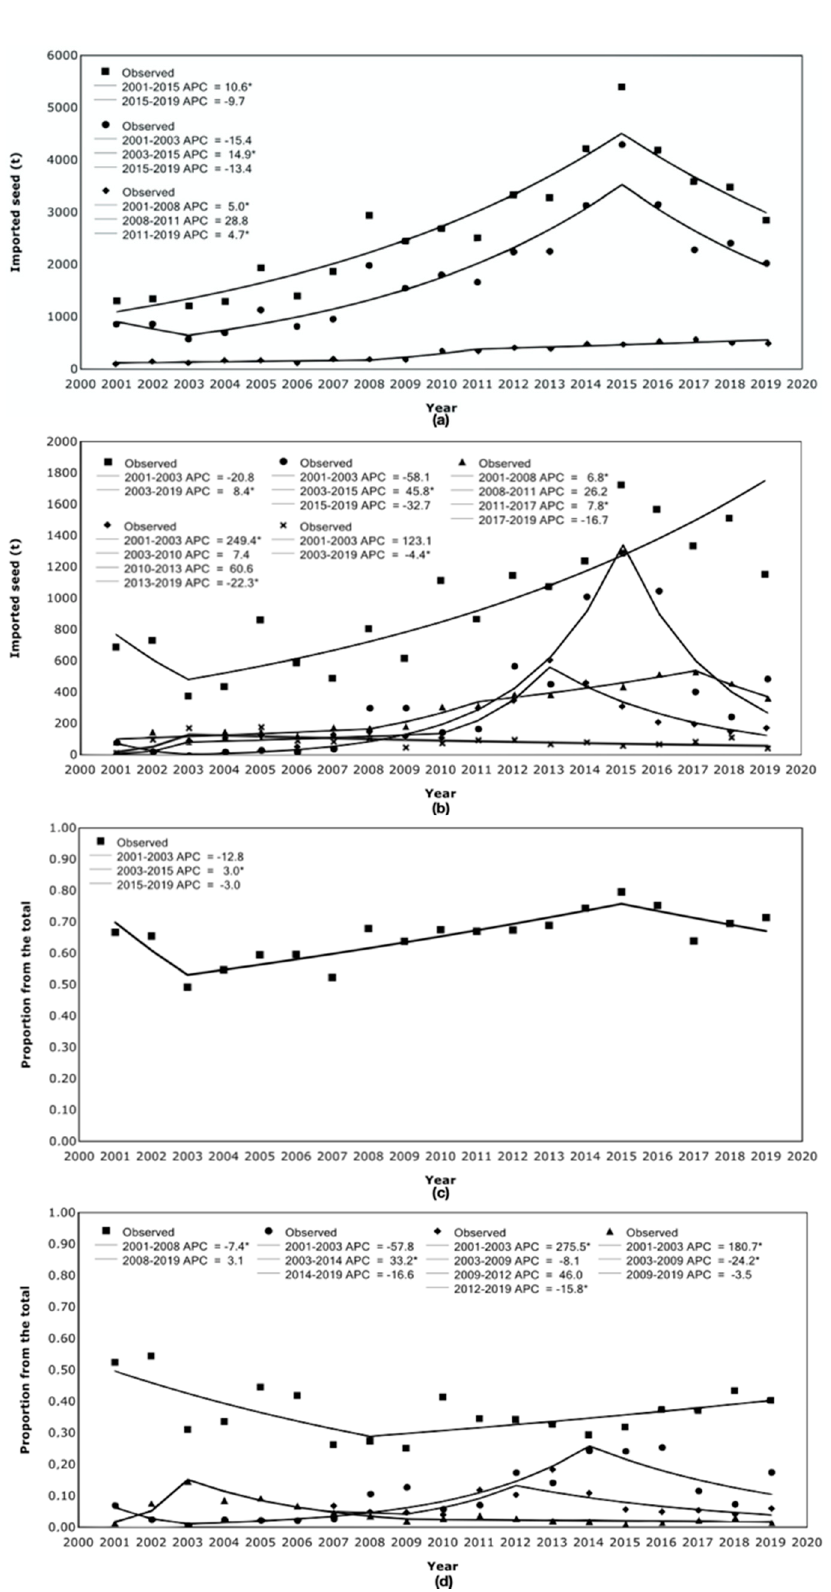
Figure 2. Joinpoint regressions (APC) for imported seed in terms of ( a ) metric tons for the total ( ∎ ), Lolium spp. ( ● ) and Festuca spp. ( ♦ ); ( b ) metric tons for the species L. perenne ( ∎ ), L. multiflorum ( ● ) , L. x hybridum ( ♦ ), F. arundinacea ( ▲ ) and T. repens (x); ( c ) proportion of the total for Lolium spp. ( ∎ ); ( d ) proportion of the total for the species L. perenne ( ∎ ), L. multiflorum ( ● ), L. x hybridum ( ♦ ) and T. repens ( ▲ ).